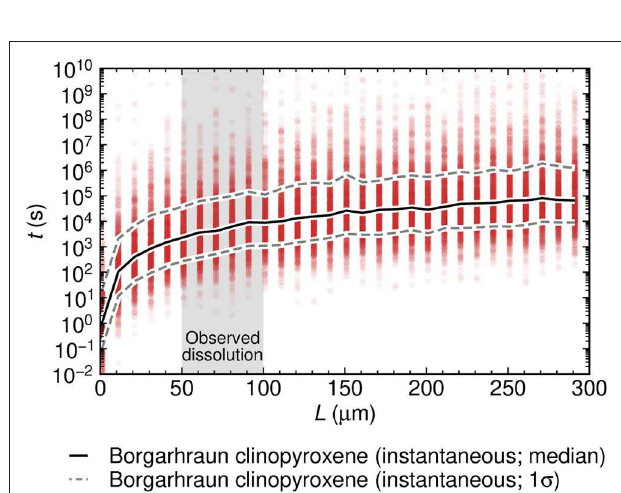
FIGURE 8 | Dissolution time as a function of dissolution length for nodule clinopyroxene cores dissolving into the Borgarhraun matrix glass upon instantaneous ascent to the surface. Red points show the result of simulations performed to evaluate the effect of uncertainties in temperature and dissolution model fitting parameters (Sugawara, 2000; Chen and Zhang, 2009; Mutch et al., 2019b). The black line shows the median dissolution time at each dissolution length; dashed gray lines represent 1 σ confidence intervals (i.e., 66% of simulations lie between the gray dashed lines). The vertical gray bar represents the range of clinopyroxene rim dissolution lengths identified from QEMSCAN and BSE images ( Figures 2 , 3 ) that constrain our best estimates of minimum dissolution